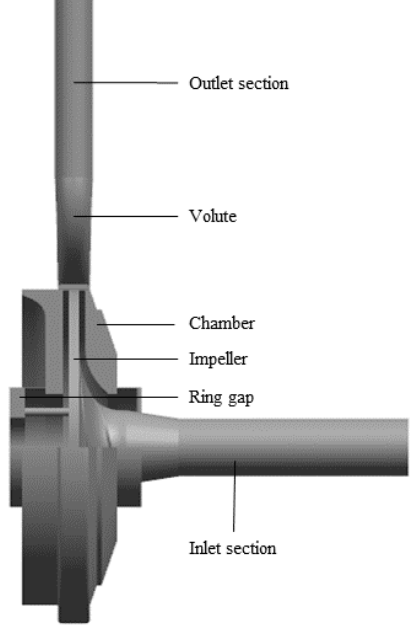
Figure 2. 3D model of full channels.